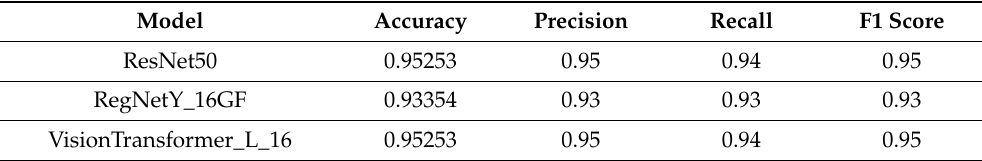
Table 5. Results for various models on DS-1 without CLAHE preprocess.